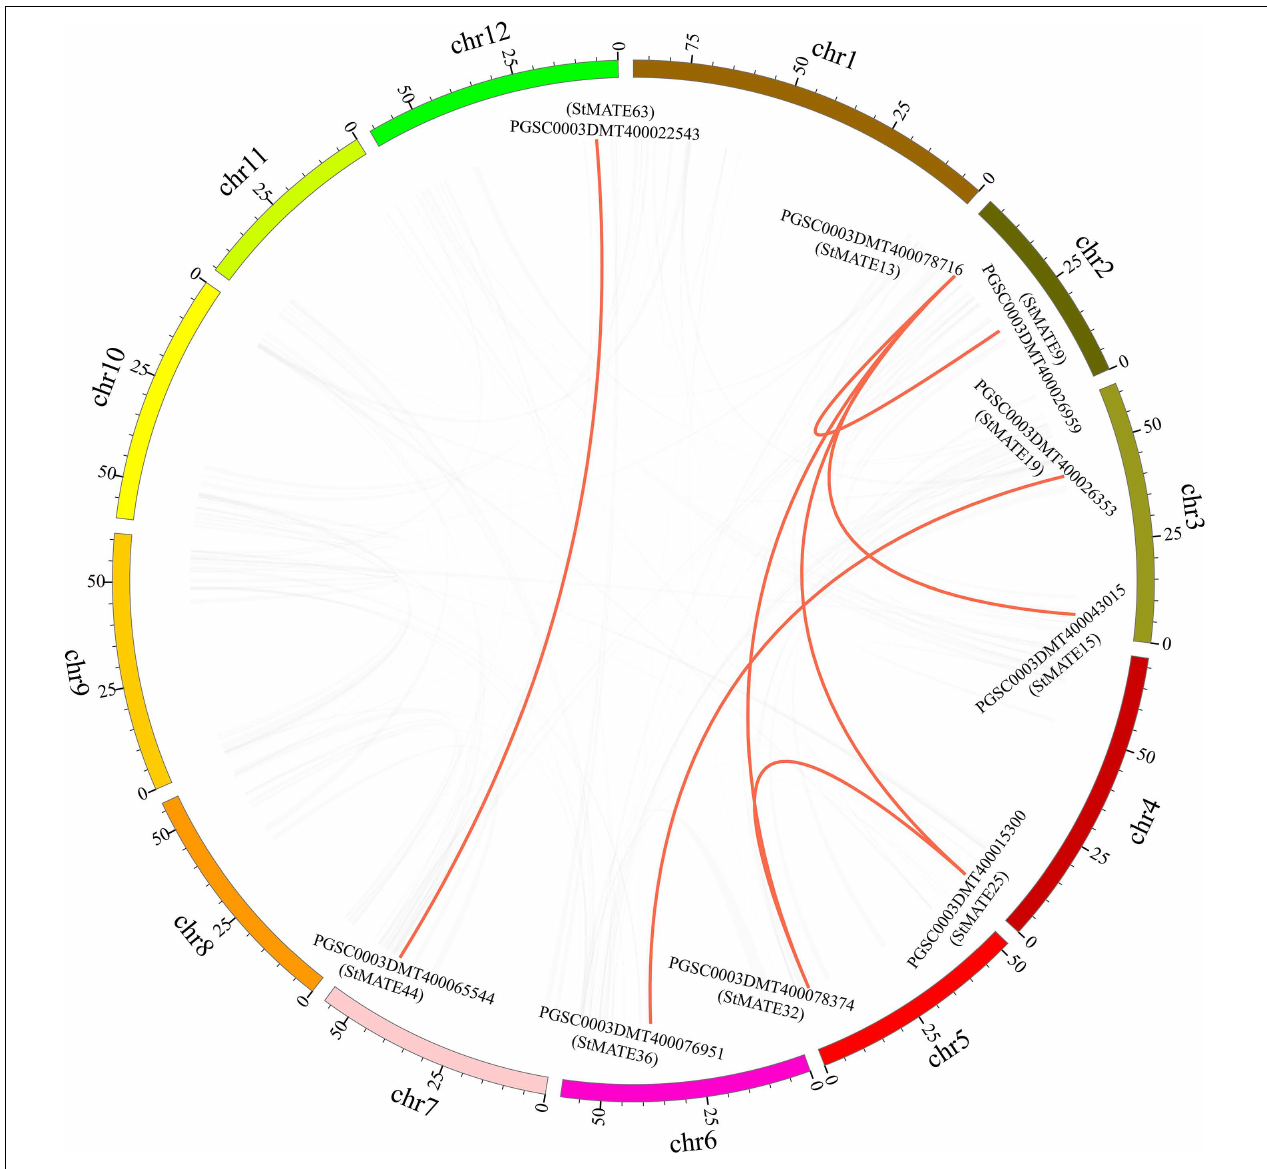
FIGURE 2 | Syntenic relationships of StMATE genes. Potato chromosomes are shown in different colors. The putative orthologous multidrug and toxic compound extrusion (MATE) genes of potato are represented in red. The gene names are indicated inside of the diagram, while the chromosome numbers are shown outside the